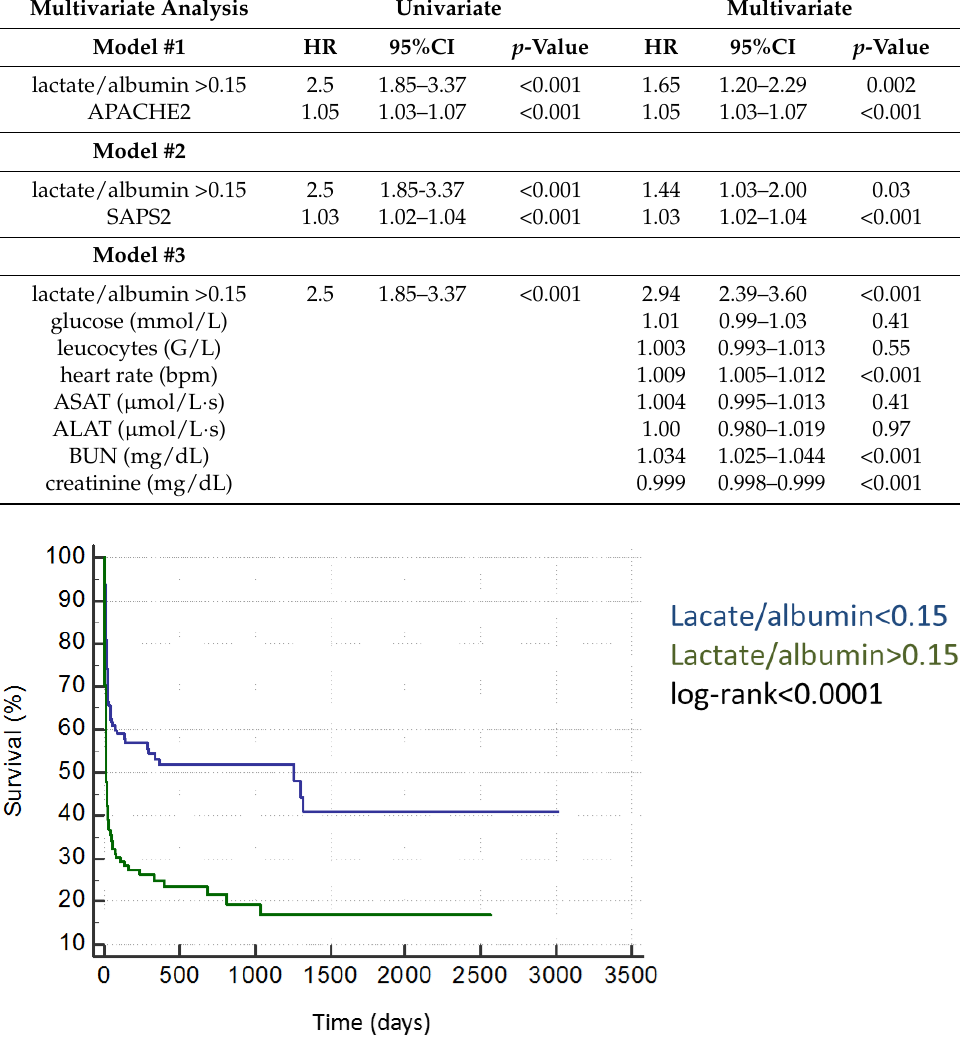
Figure 1. An increased lactate/albumin ratio is associated with adverse long-term outcome.